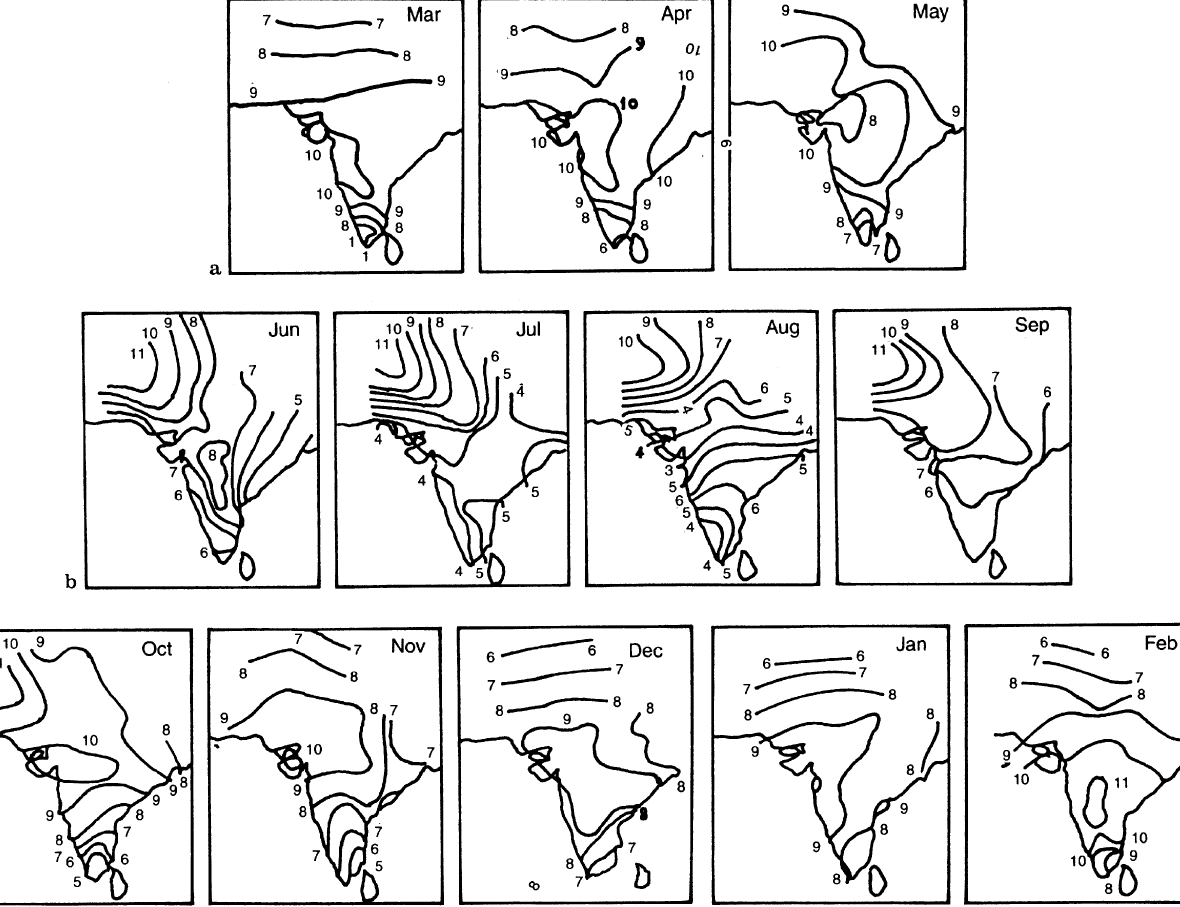
Fig. 6. Distribution of sunshine hours during a premonsoon; b monsoon; and c postmonsoon seasons over India Pakistan. In the arid and semi-arid zones of central and northwest India, the skies are clear for generally more than 8 — 10 h a